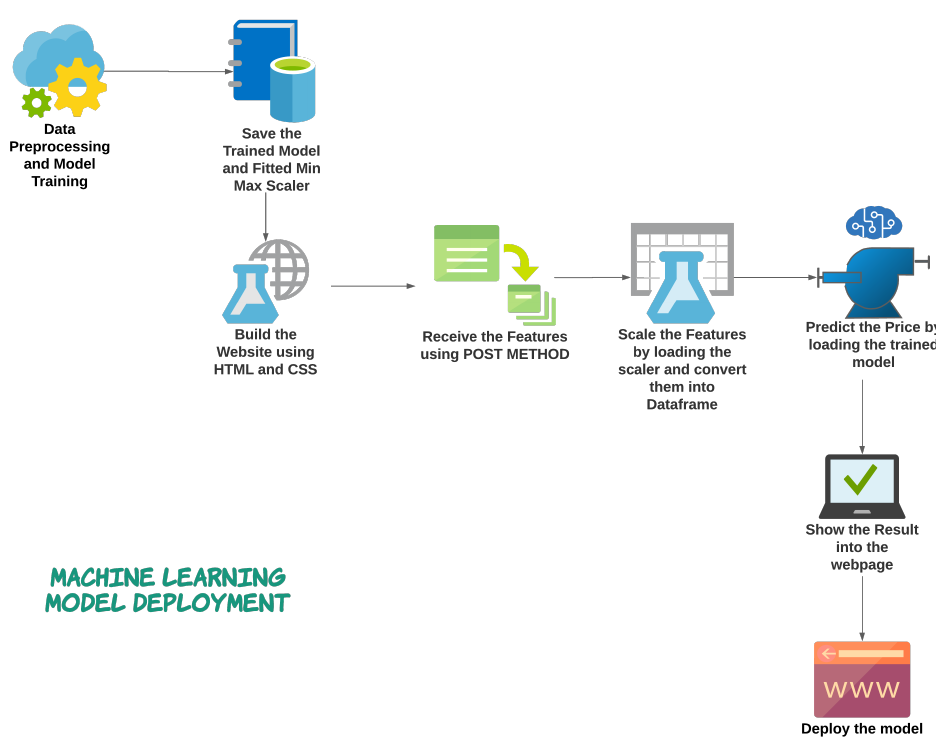
Figure 22. Architectural diagram of the deployment